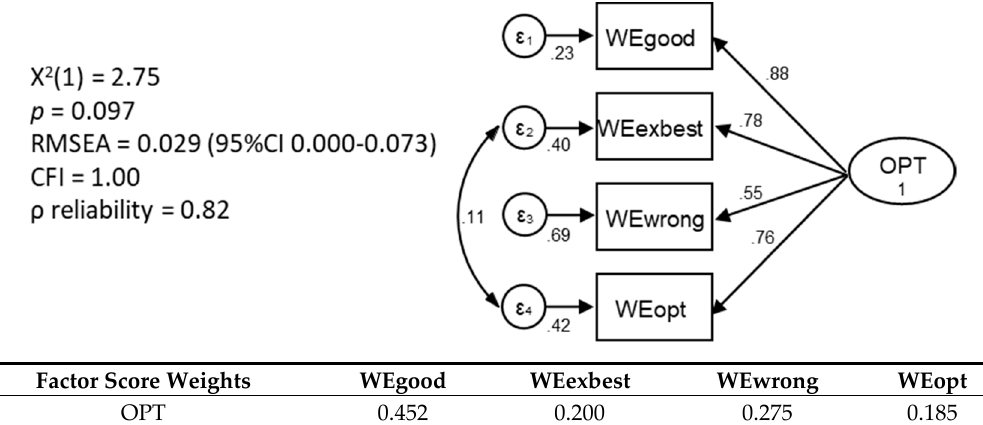
Figure A6. Final model for Trait Optimism construct of personal social cohesion.